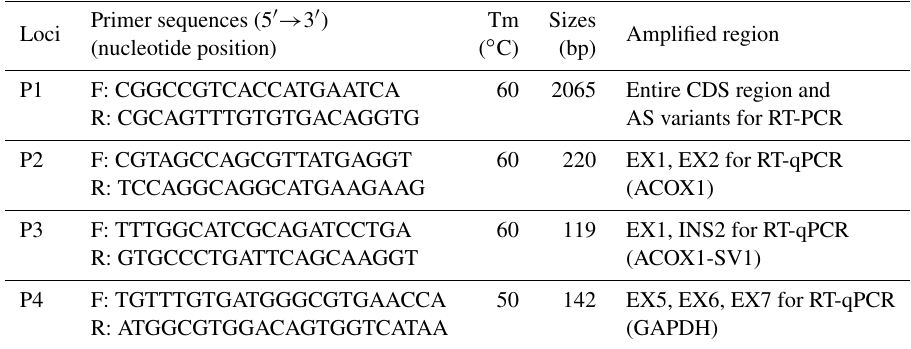
Amplified region